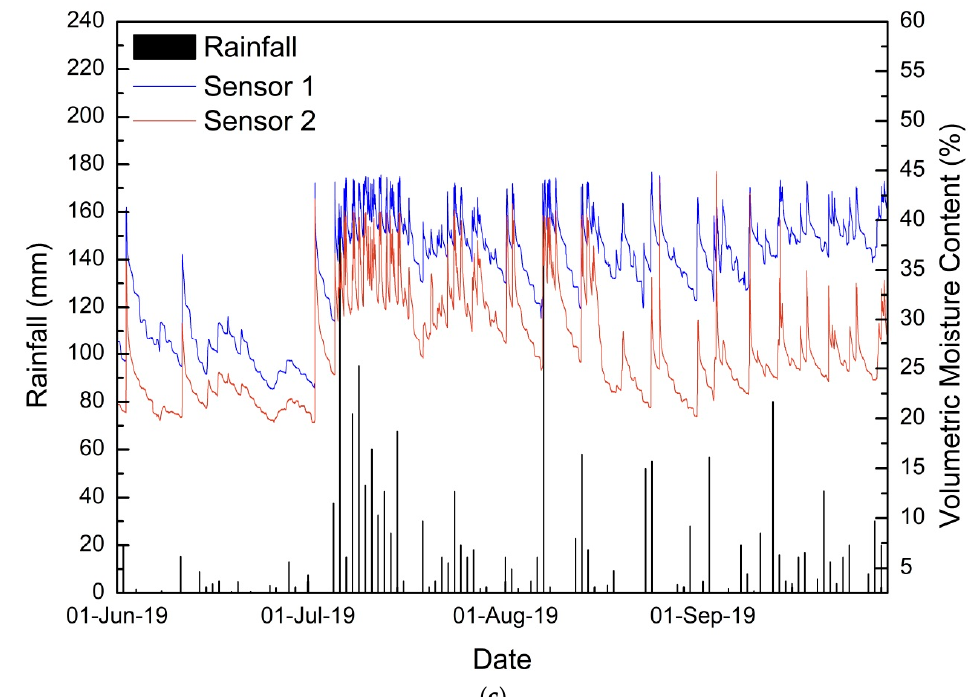
Figure 12. Detailed time history for the monsoon 2019 of sensors 1 and 2: ( a ) tilting angle in the direction parallel to the slope, ( b ) tilting angle in the direction perpendicular to the slope, and ( c ) volumetric moisture content.